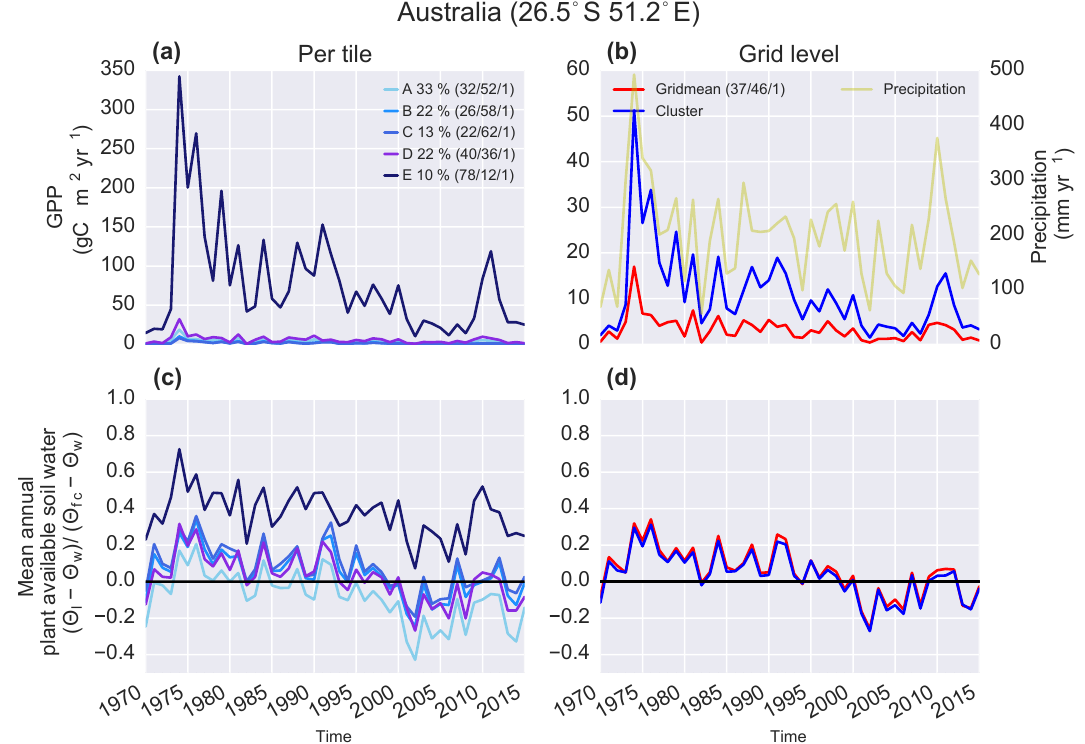
Figure 9. Australian grid cell that has higher GPP for the Cluster simulation than the Gridmean simulation, but lower soil moisture. A measure of the mean annual plant-available soil water, scaled so that 1 indicates field capacity and 0 is the wilting point, is calculated for the second model soil layer (0.1–0.35m) and is described in Sect. 3.3.2. The annual precipitation for this grid cell from CRU-NCEP is included for reference in panel (b)